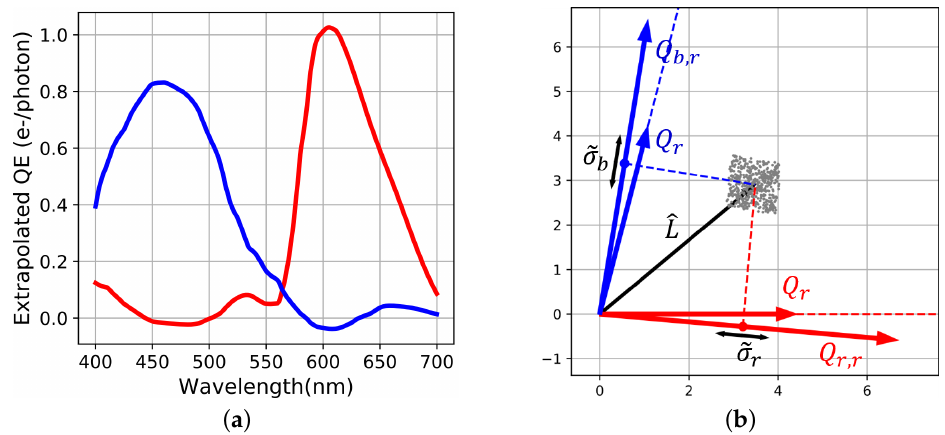
Figure 9. Tikhonov regularization ( a ) Extrapolated spectral sensitivities. ( b ) Spectral reconstruction with α = 15. The orthogonal projections of signals and standard deviation (cid:101) S i and (cid:101) σ i are found with Equation (8) replacing (cid:107) Q r (cid:107) and (cid:107) Q b (cid:107) by (cid:107) Q r , r (cid:107) . 2 2 2